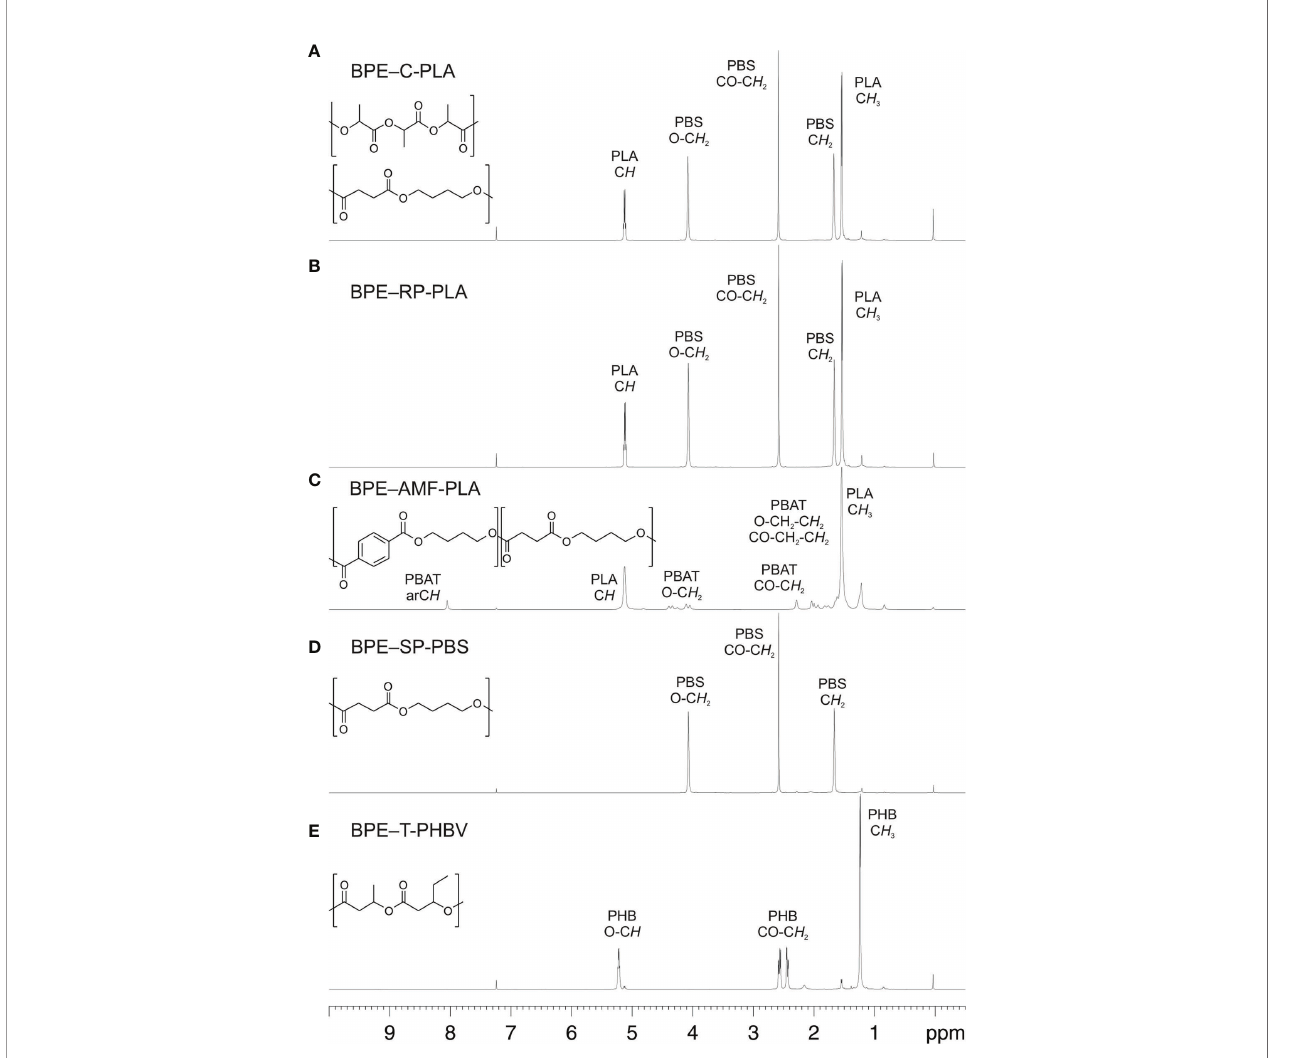
FIGURE 1 | 1 H-NMR spectra of the investigated BPE materials (structures shown on the left): (A) BPE-C-PLA, (B) BPE-RP-PLA, (C) BPE-AMF-PLA, (D) BPE-SP- PBS, and (E) BPE-T-PHBV. For all spectra the region between 0.5 and 10 ppm is shown. The BPE peaks are